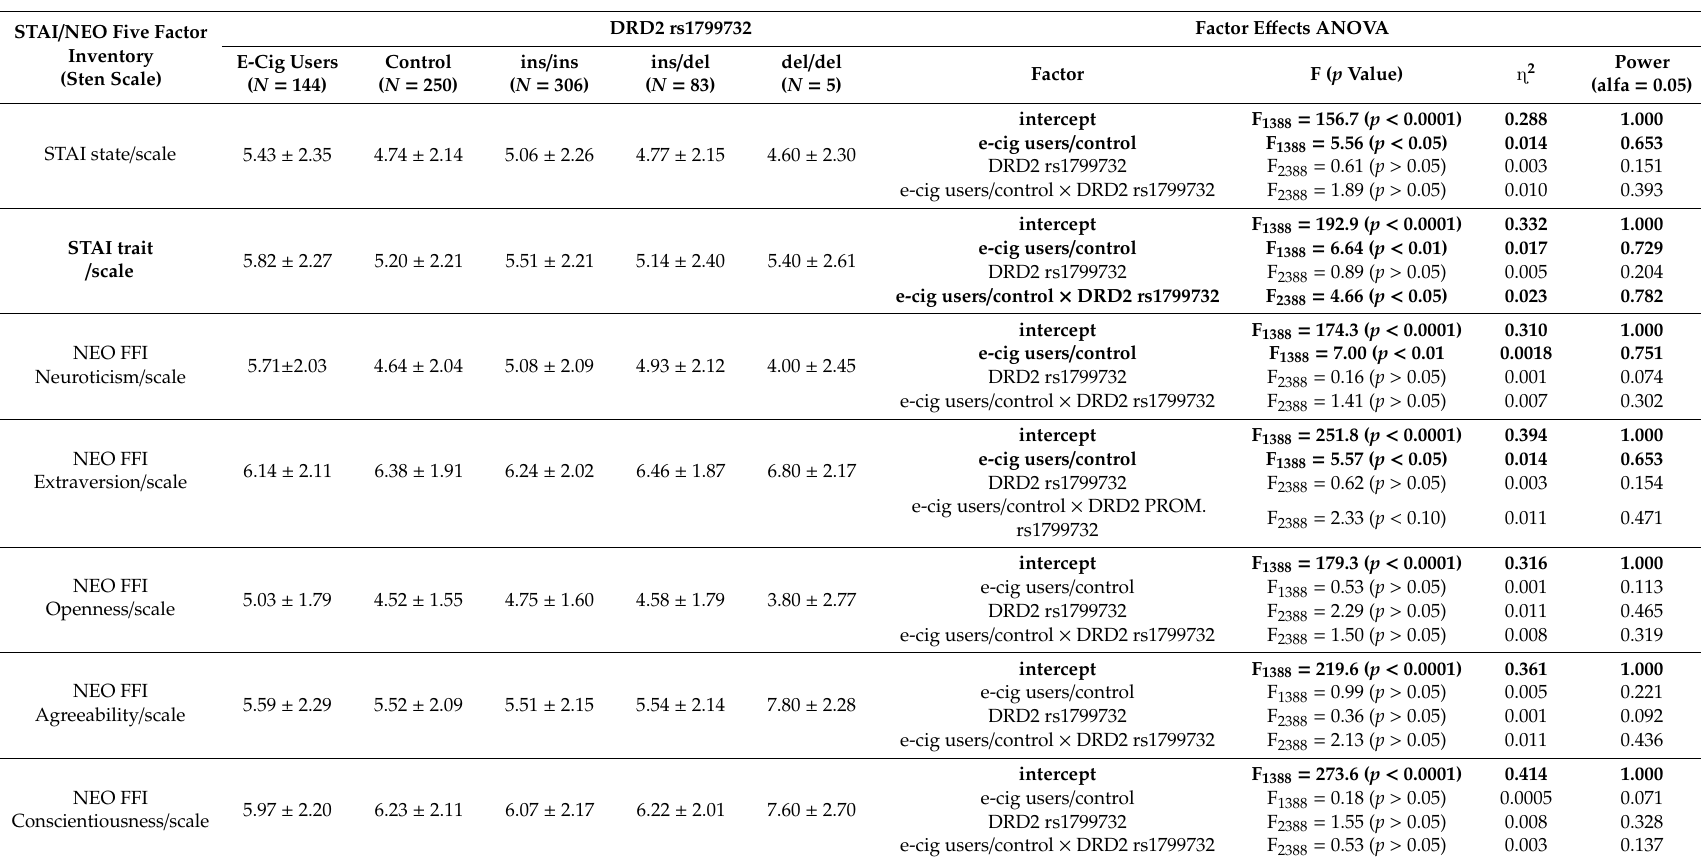
Table 5. Di ff erences in DRD2 rs1799732 and STAI / NEO Five Factor Inventory between control subjects and e-cigarette